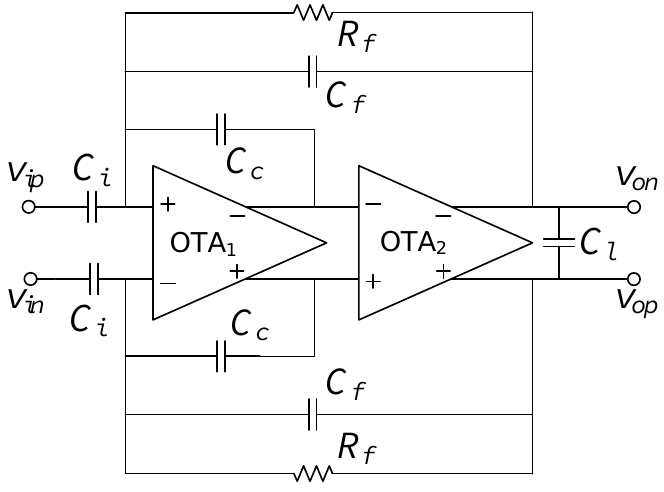
Figure 5. Feedforward Compensated Capacitive feedback network LNA